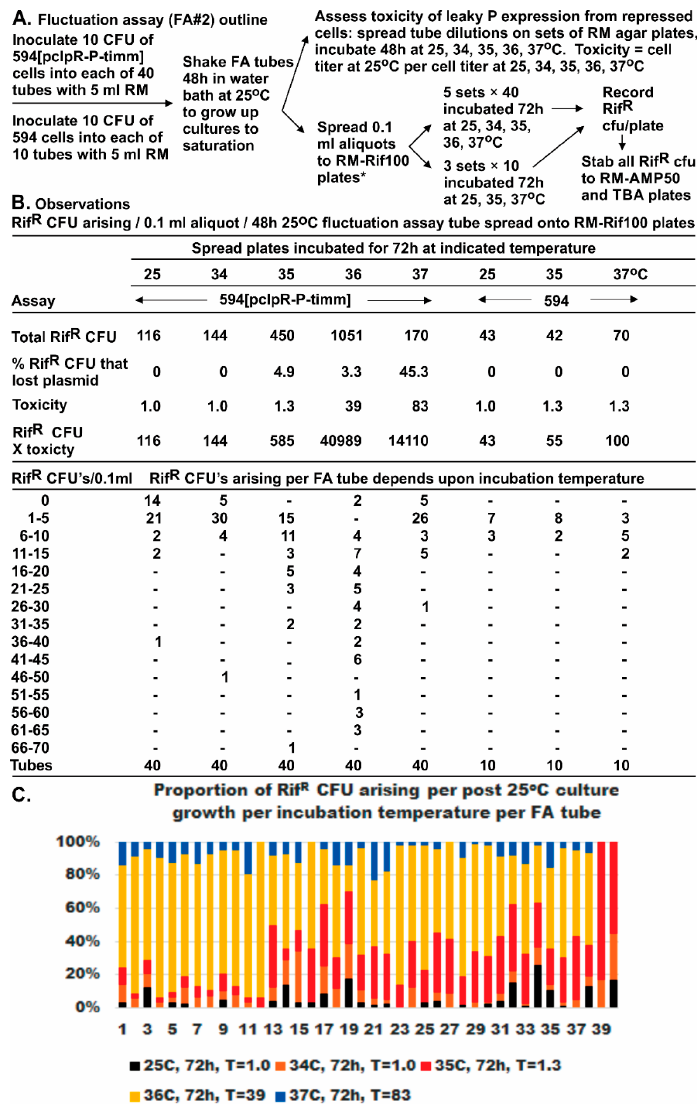
Figure 3. Fluctuation assay to examine the influence of P expression on the screen for Rif R CFU: ( A ) outline of methodology; ( B ) observations; and ( C ) relative proportion of Rif R CFU arising on spread plates incubated in parallel at 25 °C to 37 °C, where T = the toxicity of the treatment, determined by CFU formed on RM plates without rifampicin at 25 °C per CFU formed on RM plates without rifampicin after incubation at 25, 34, 35, 36, or 37 °C.